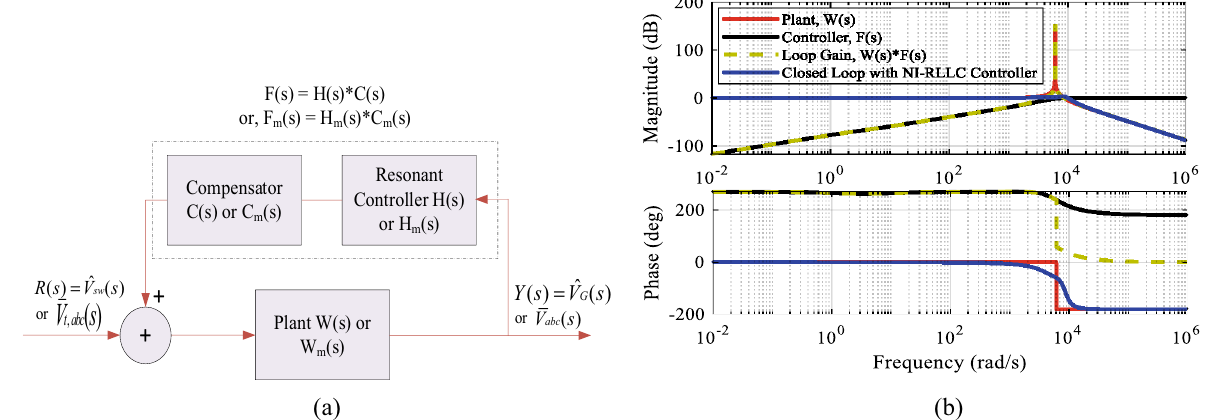
Fig. 3 a Closed‑loop control structure of MG system both for single‑phase and three‑phase b bode plot of different transfer functions for single‑phase